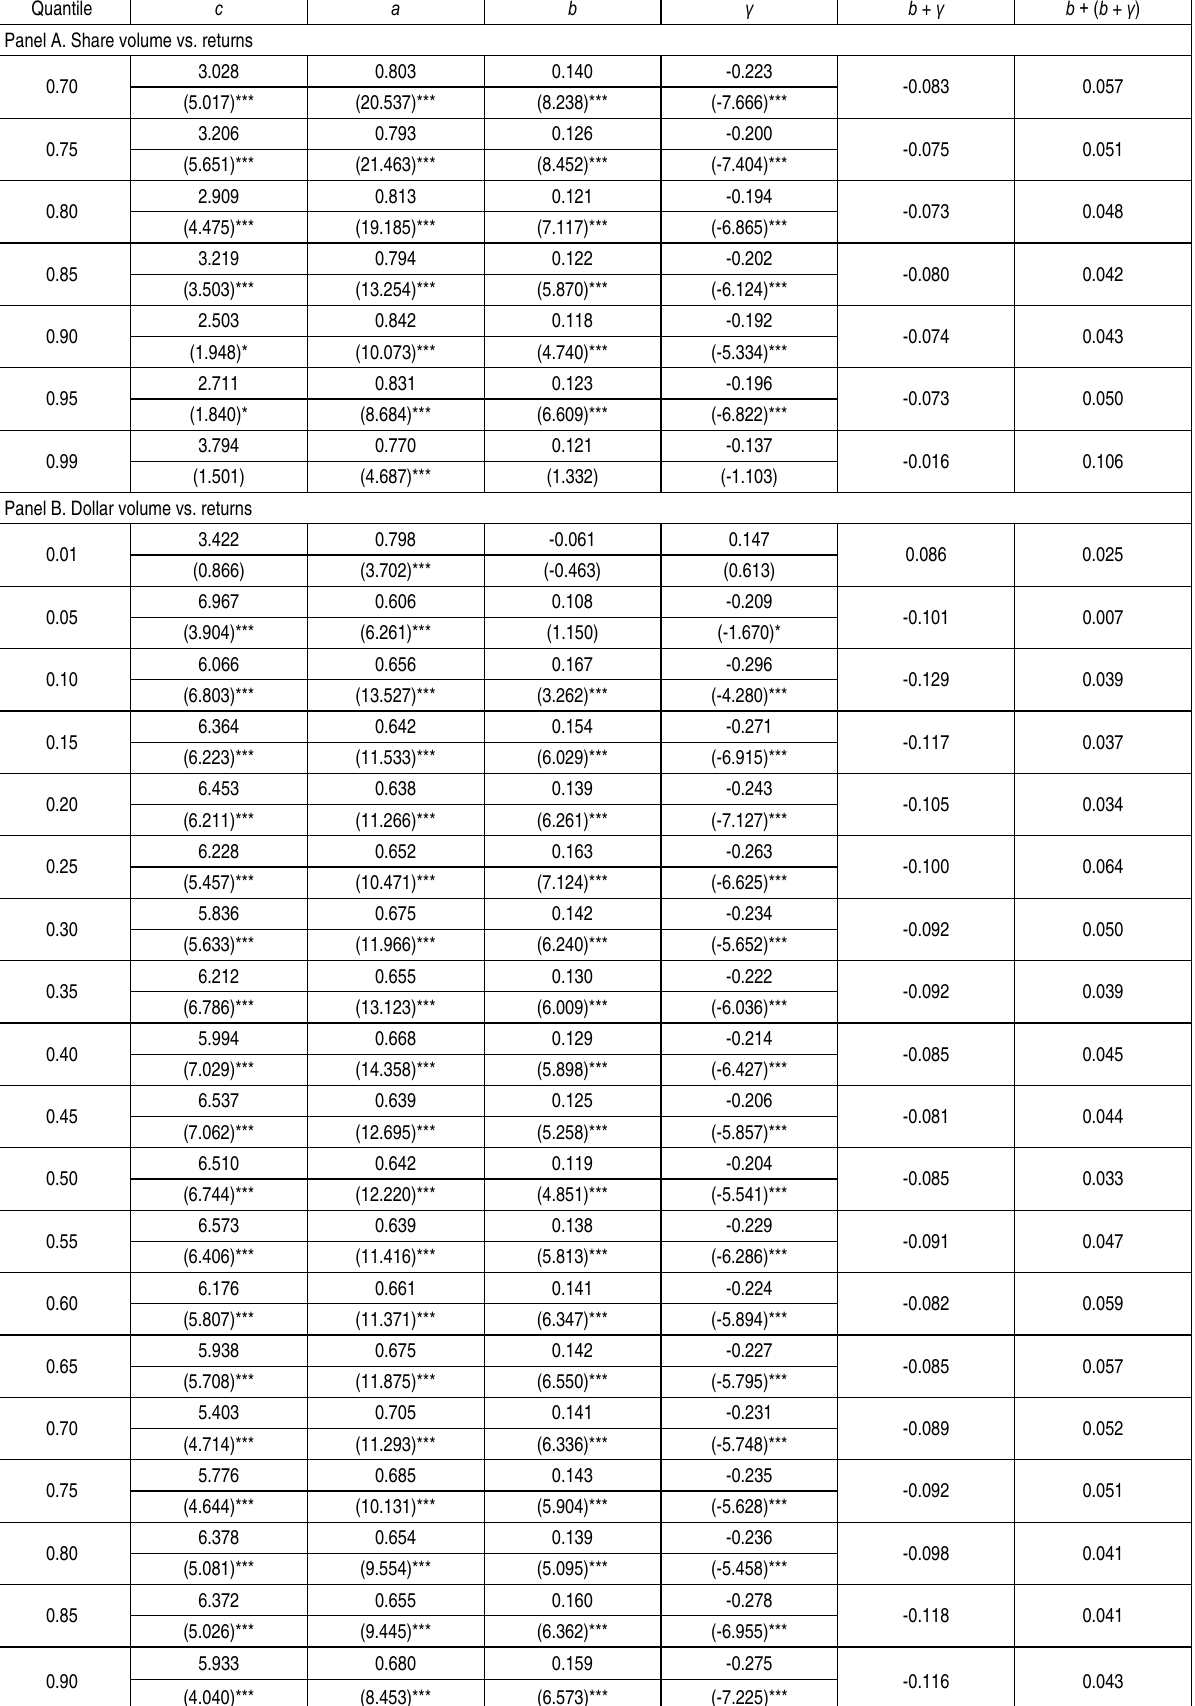
Table 8 (cont.). Quantile regression estimates of volume-signed return correlation for TAIEX in the entirely-eliminated